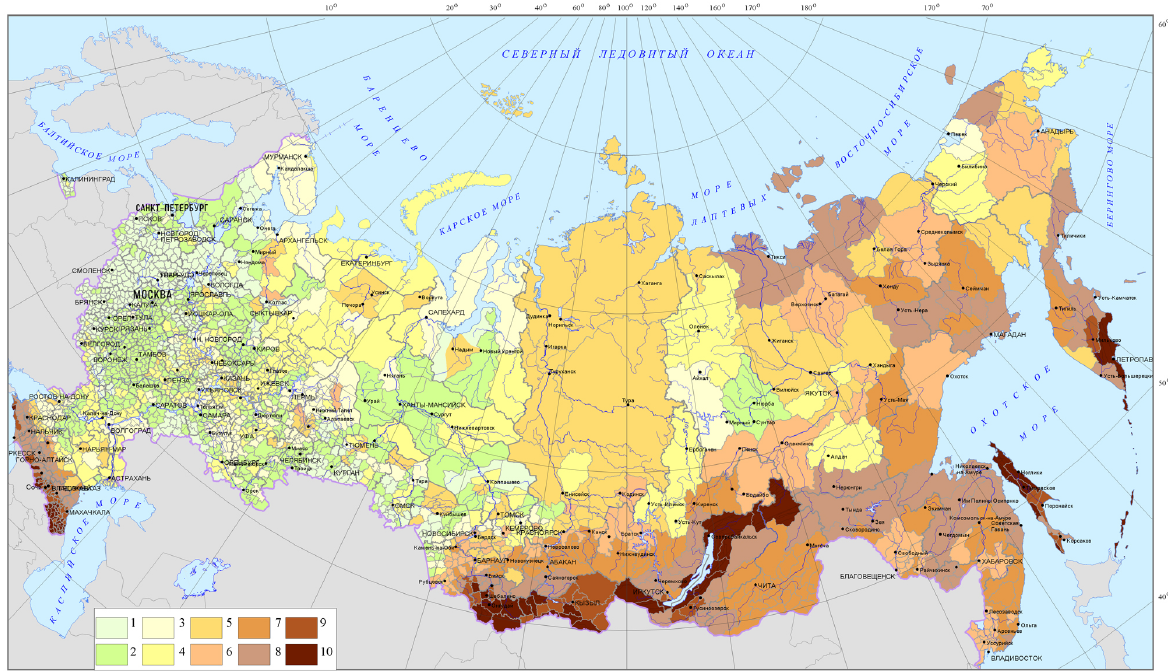
Figure 14. Individual natural risk R 3 for the population of the Russian Federation: risk R s 2, 10 − 5 1 per year categories: 1 – less than 0.1; 2 – 0.1 up to 1; 3 – 1 up to 2; 4 – 2 up to 5; 5 – 5 up to 10; 6 – 10 up to 15; 7 – 15 up to 30; 8 – 30 up to 100; 9 – 100 up to 150; 10 – more than 150; map based on layers from